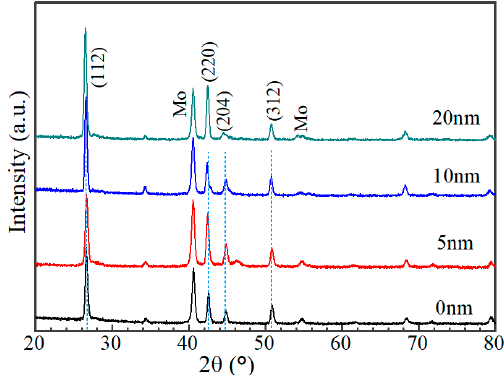
ff erent thicknesses of Na 2 Se. Figure 9. XRD patterns of AIGS films with different thicknesses of Na 2 Se.